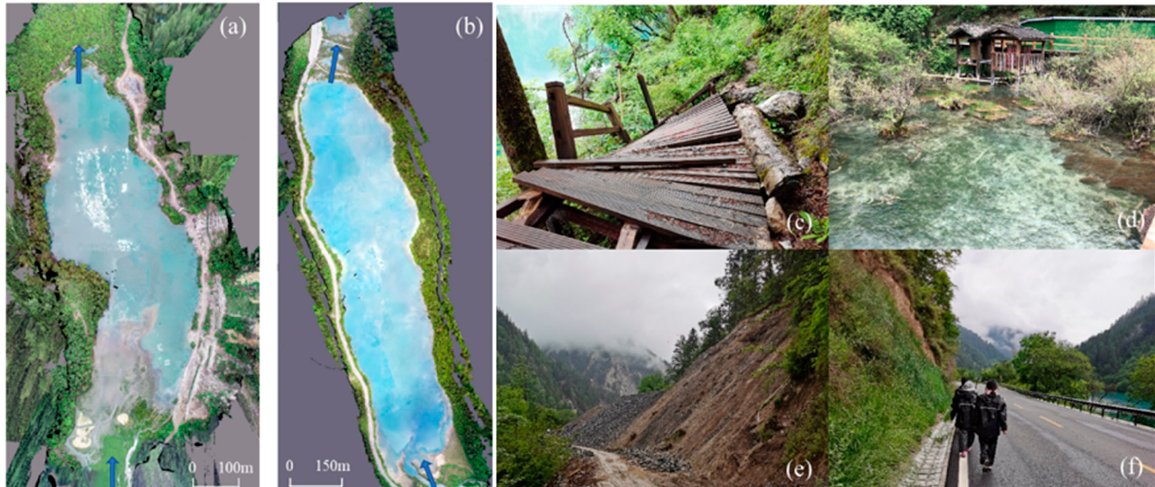
Figure 2. Digital orthophoto maps of ( a ) Arrow Bamboo Lake and ( b ) Rhino Lake (2020). ( c ) and ( e ) Field photos of the forest-side and road-side of Arrow Bamboo Lake, respectively; and ( d ) and ( f ) field photos of the forest-side and road-side of Rhino Lake, respectively.